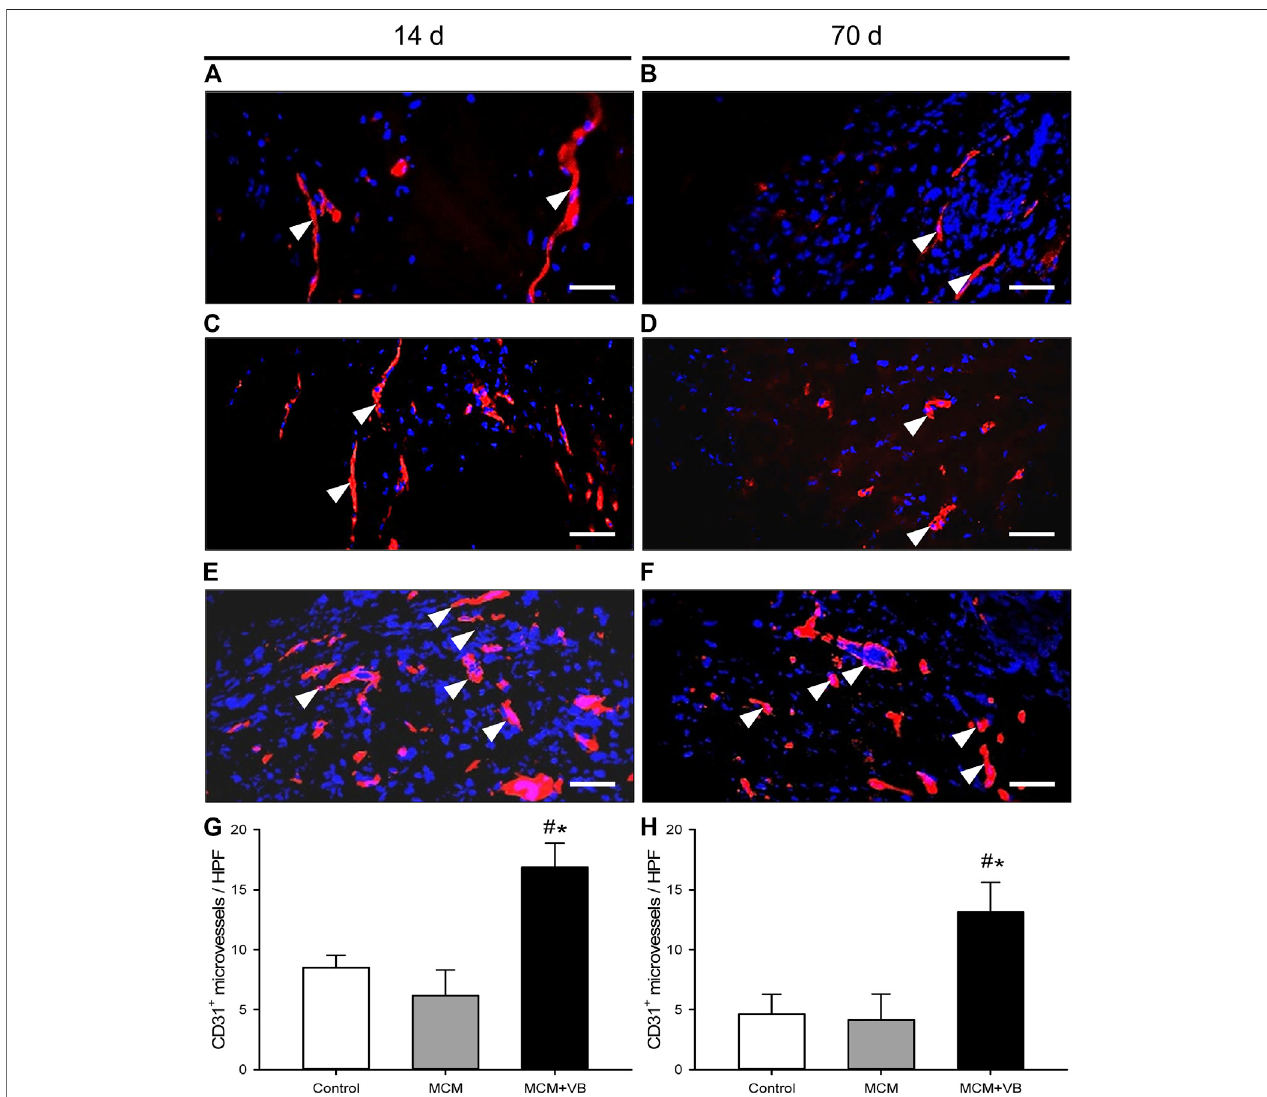
FIGURE 6 | Immunohistochemical analysis of microvessels in the central healing zone of the periosteal callus. A-F : Immunohistochemical detection of CD31 + microvessels(arrowheads)withinthe callus tissue ofosteotomized femurs ofcontrol (A, B) ,MCM (C, D) and MCM +VB (E, F) animalsat 14 days (A, C,E) and 70 days (B, D, F) after osteotomy.Bars represent 50 µm. G, H: Number ofCD31 + microvesselsper HPF ofcontrol (n (cid:1) 4), MCM (n (cid:1) 4) and MCM + VB(n (cid:1) 4) femurs at 14 days (G) and 70 days (H) after osteotomy. Mean ± SEM; # p < 0.05 vs control; * p < 0.05 vs